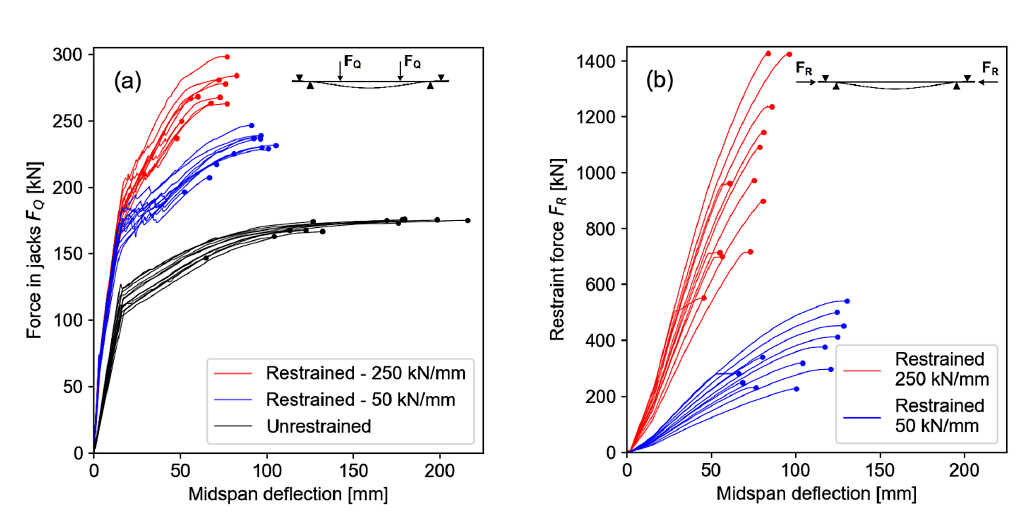
; (b) PDF of the ultimate restraint force F Q,max